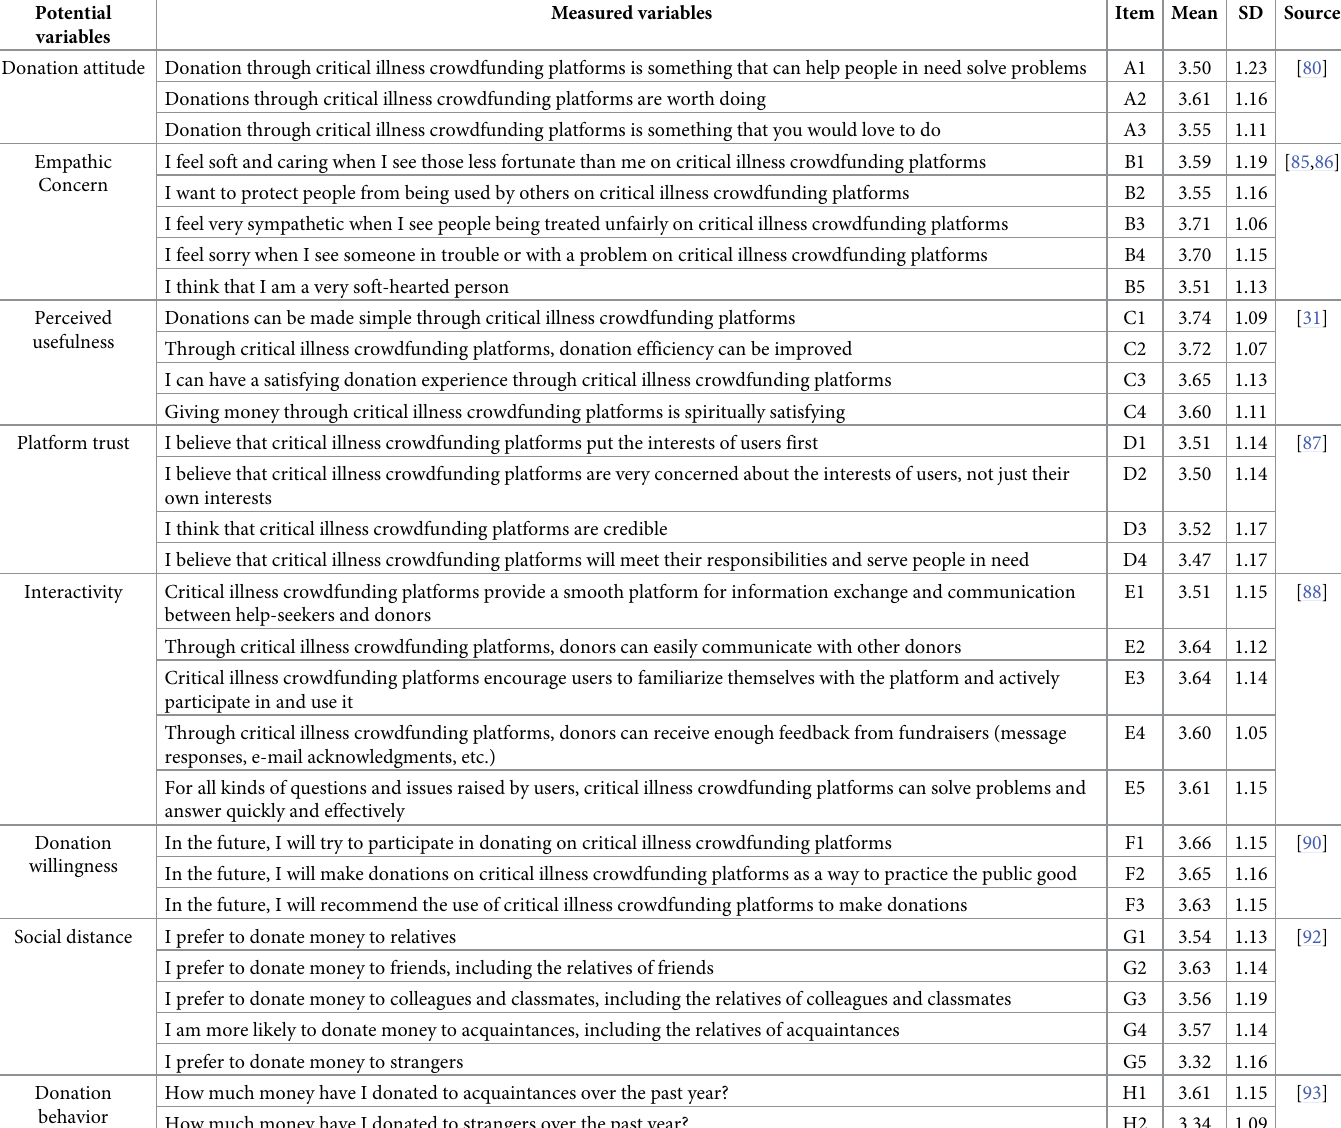
Table 1. Factor loadings, descriptive statistics and scale sources of each measured